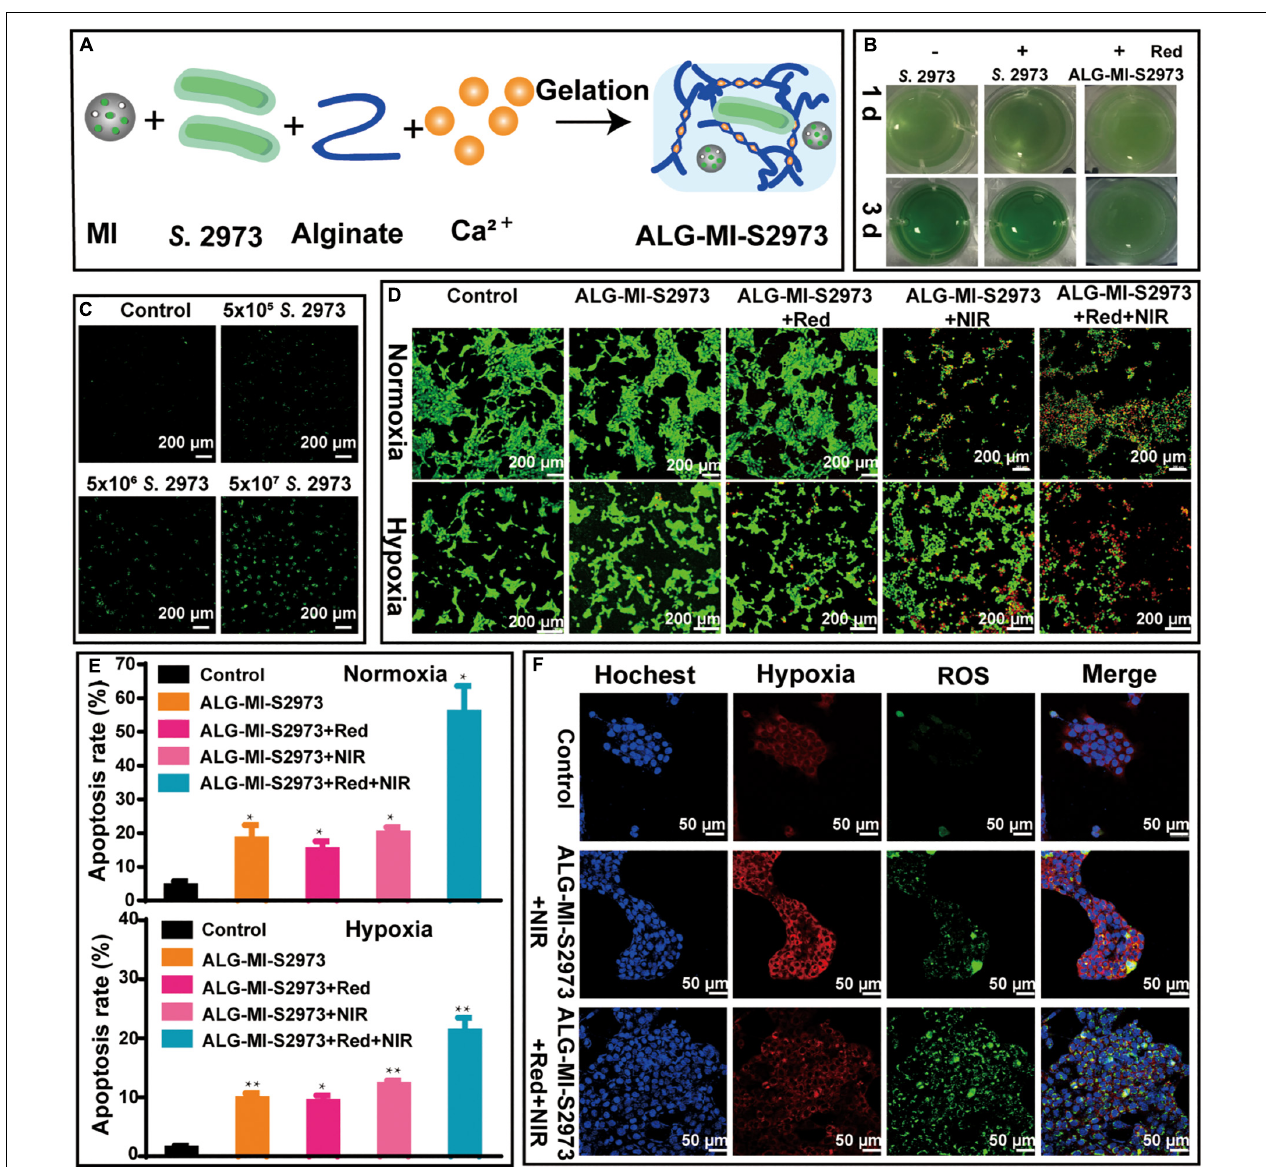
FIGURE 4 | Construction and characterization of injectable hydrogels packing MSN-ICG and/or S . 2973. (A) The preparation of injectable hydrogels packing MSN-ICG and S. 2973 (i.e., ALG-MI-S2973). (B) Growth investigation of S . 2973 directly in BG11 or packaged in ALG-MI-S2973 cultivated under normal or 640 nm irradiation. (C) The ROS generation in 4T1 cells after treatment of ALG-MI-S2973 with different amounts of S . 2973. (D,E) AM/PI staining and cell apoptosis analysis of 4T1 cells treated with or without ALG-MI-S2973 under control, 808 nm irradiation or both 640 and 808 nm irradiation. (F) Measurements of hypoxia and ROS of normoxia 4T1 cells treated with or without ALG-MI-S2973 under control, 808 nm irradiation or both 640 and 808 nm irradiation. * p < 0.05, ** p < 0.01 compared with untreated group by Student’s t -test. MSN-ICG, indocyanine green-loaded mesoporous silica nanoparticles; ALG-MI-S2973, hydrogels packaging MSN-ICG and S .